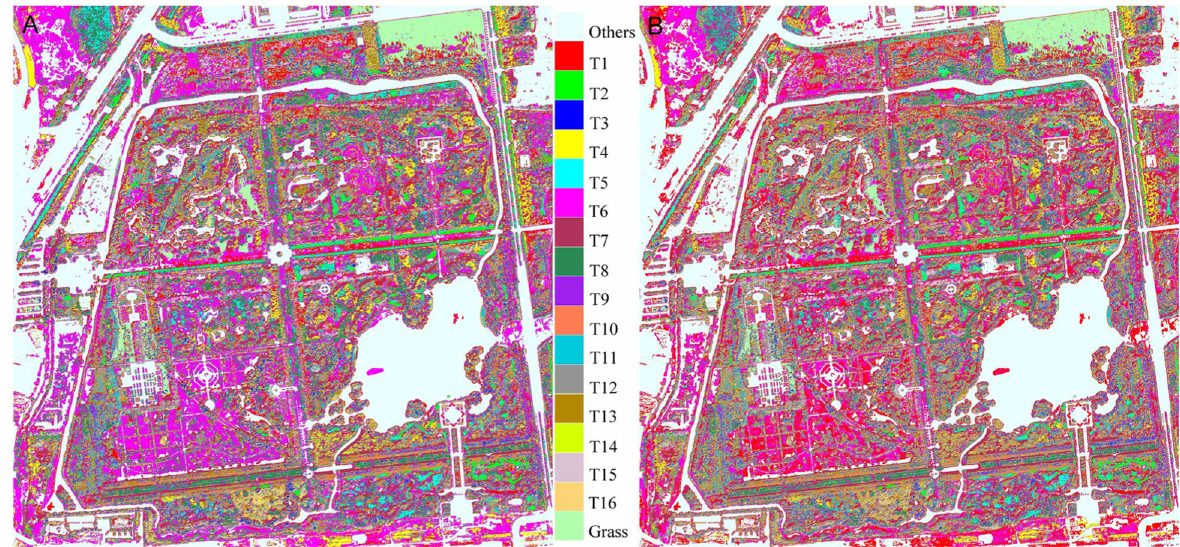
Fig. 5 Representative classification result maps used to compare visually and analyse the classification results. A Classification result of the optimal feature set, obtained by extracting polygon area index features based on algorithm 3. B Classification result of the 8-band WorldView-3